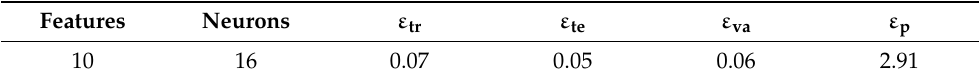
Table 9. Selected model results.